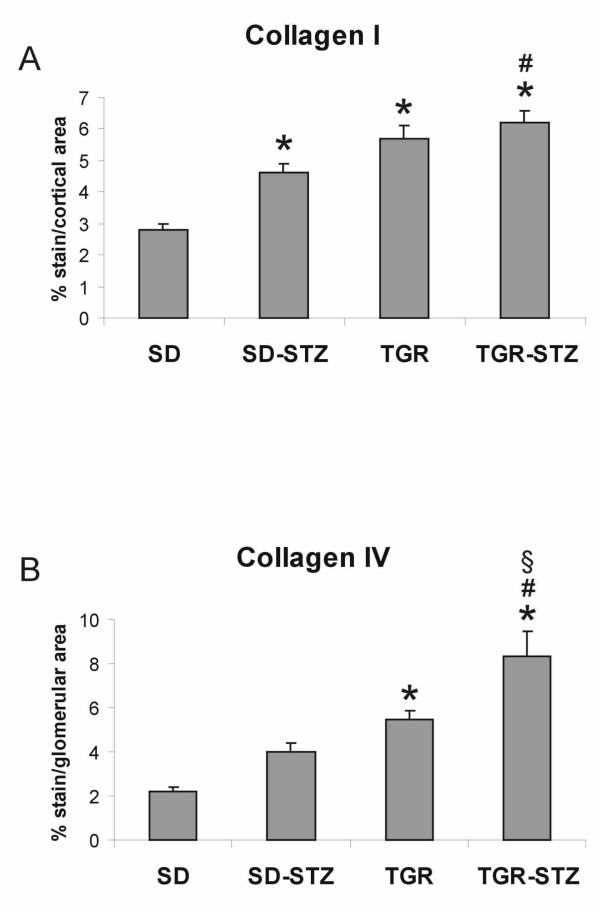
Matrix expansion in the renal cortex and the glomerulus. A: measurement of cortical collagen I staining and B: measurement of glomerular collagen IV staining. Data are mean ± SEM, * indicates p < 0.05 versus normotensive normoglycemic SD controls. # indicates p < 0.05 versus SD-STZ. § indicates p < 0.05 versus normoglycemic TGR.